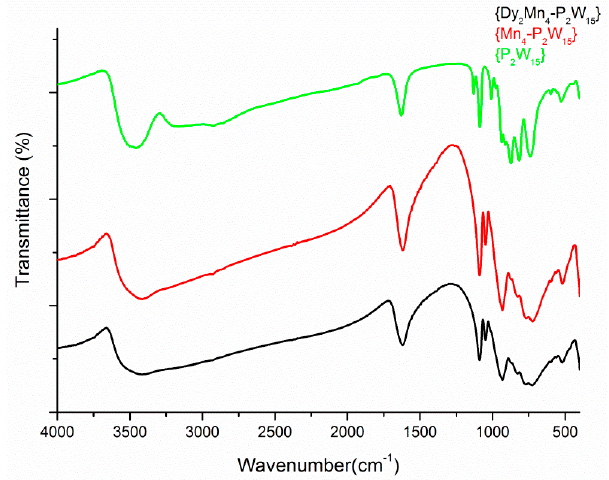
Figure 4. Fourier transform infrared (FT-IR) spectroscopy of Dy 2 Mn 4 -P 2 W 15 , Mn 4 -P 2 W 15 , and P 2 W 15 .